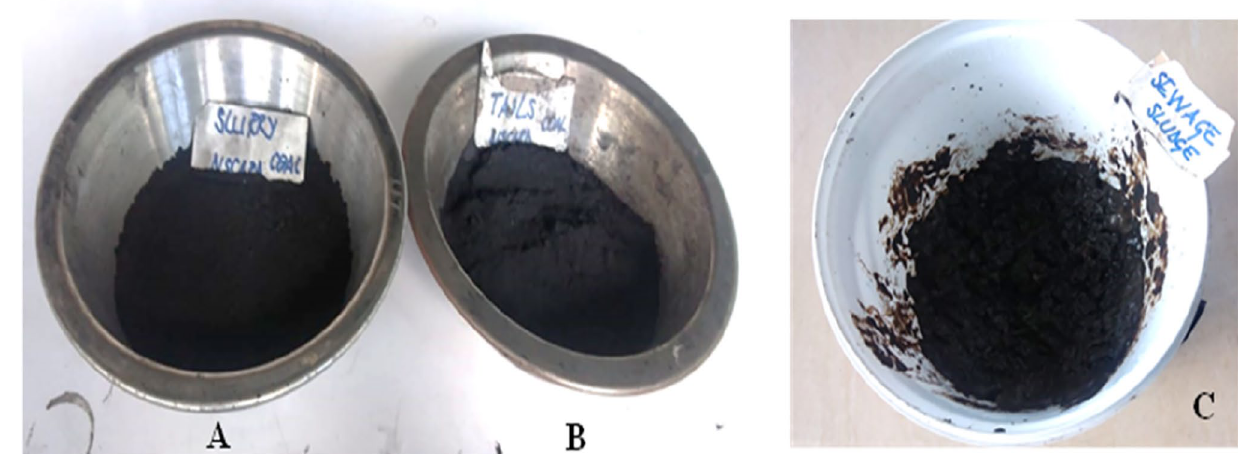
Figure 1. collected waste coal slurry ( A ), waste coal tailing ( B ) and sewage sludge sample ( C